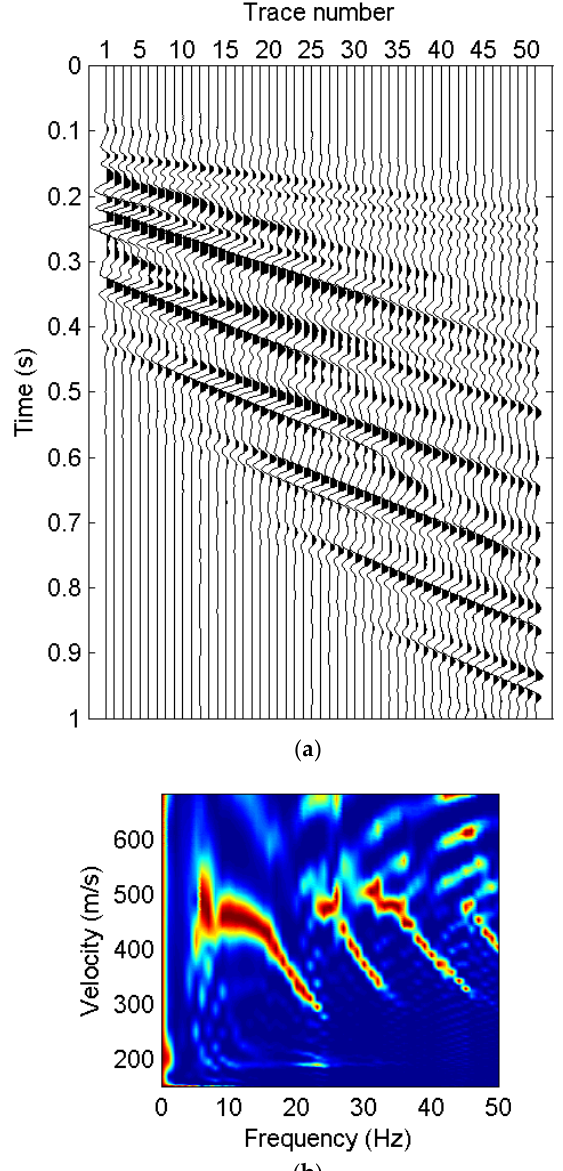
Figure 4. ( a ) A synthetic X-component shot gather of Model 3 and ( b ) its image of dispersive energy in the f-v domain.